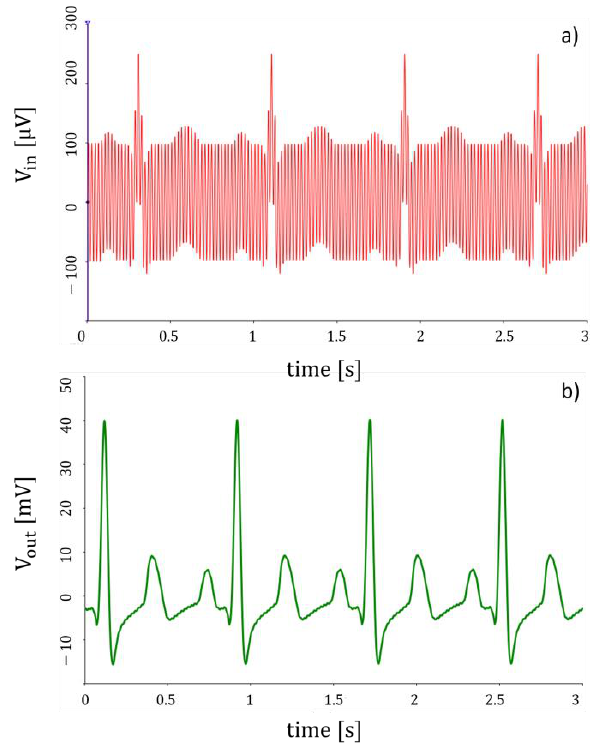
Figure 10. Simulation of the ( a ) input signal ( b ) output signal.